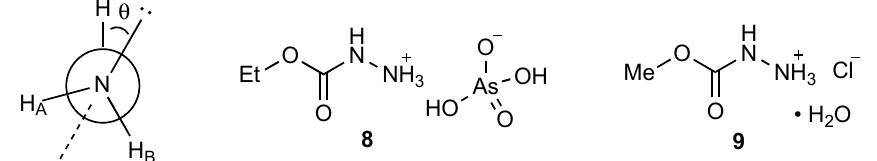
Figure 2. Definition of the twist angle for 1 and the structure of the comparison compounds 8 and 9.